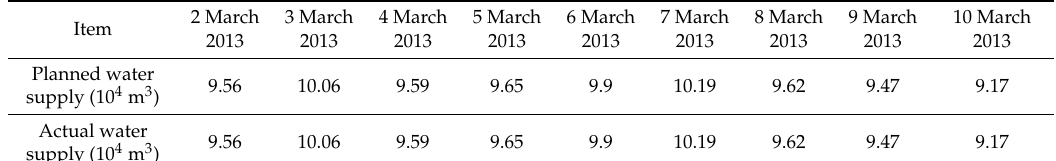
Table 8. The water operation process of the Shiyan waterworks.